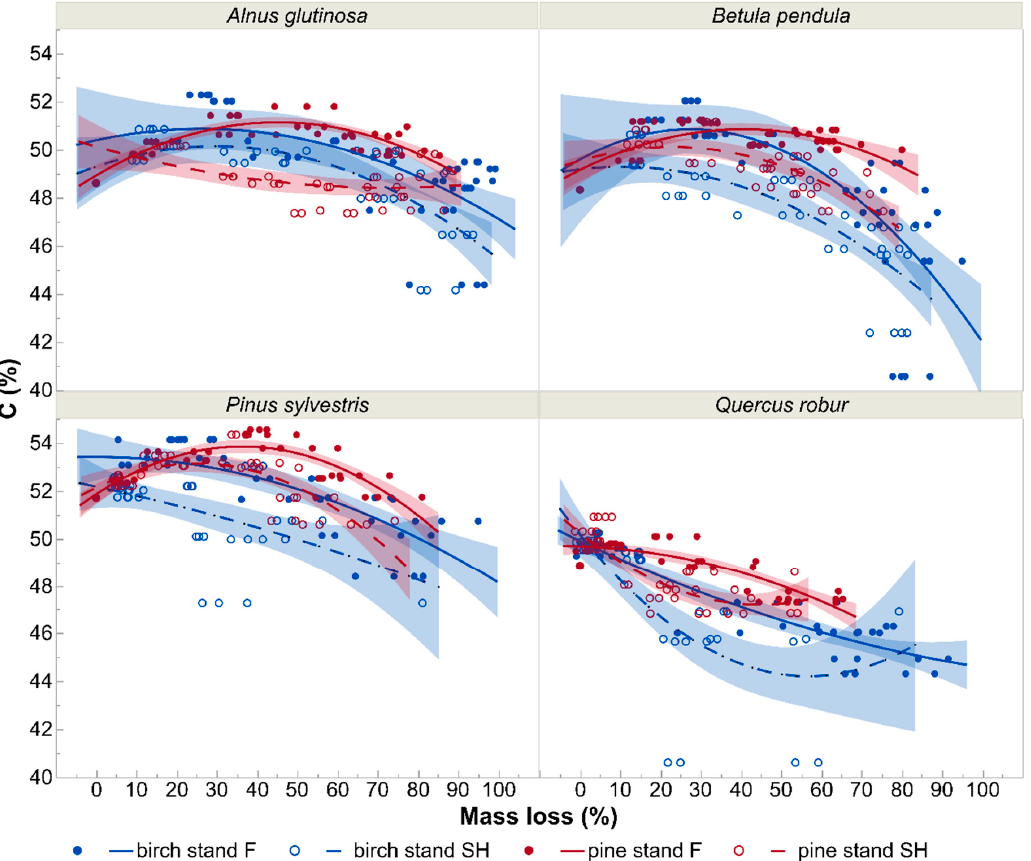
Figure 6. Effects of decomposition level on carbon concentration (C; %) of particular tree species leaf litter in birch and pine stands growing in two different site types—post-mining external spoil heap (SH) or forest sites (F). Visualization is based on quadratic models with 95% confidence intervals for the predicted values. The markers on the graph show mean values of carbon concentrations of particular tree species at particular decomposition stages.